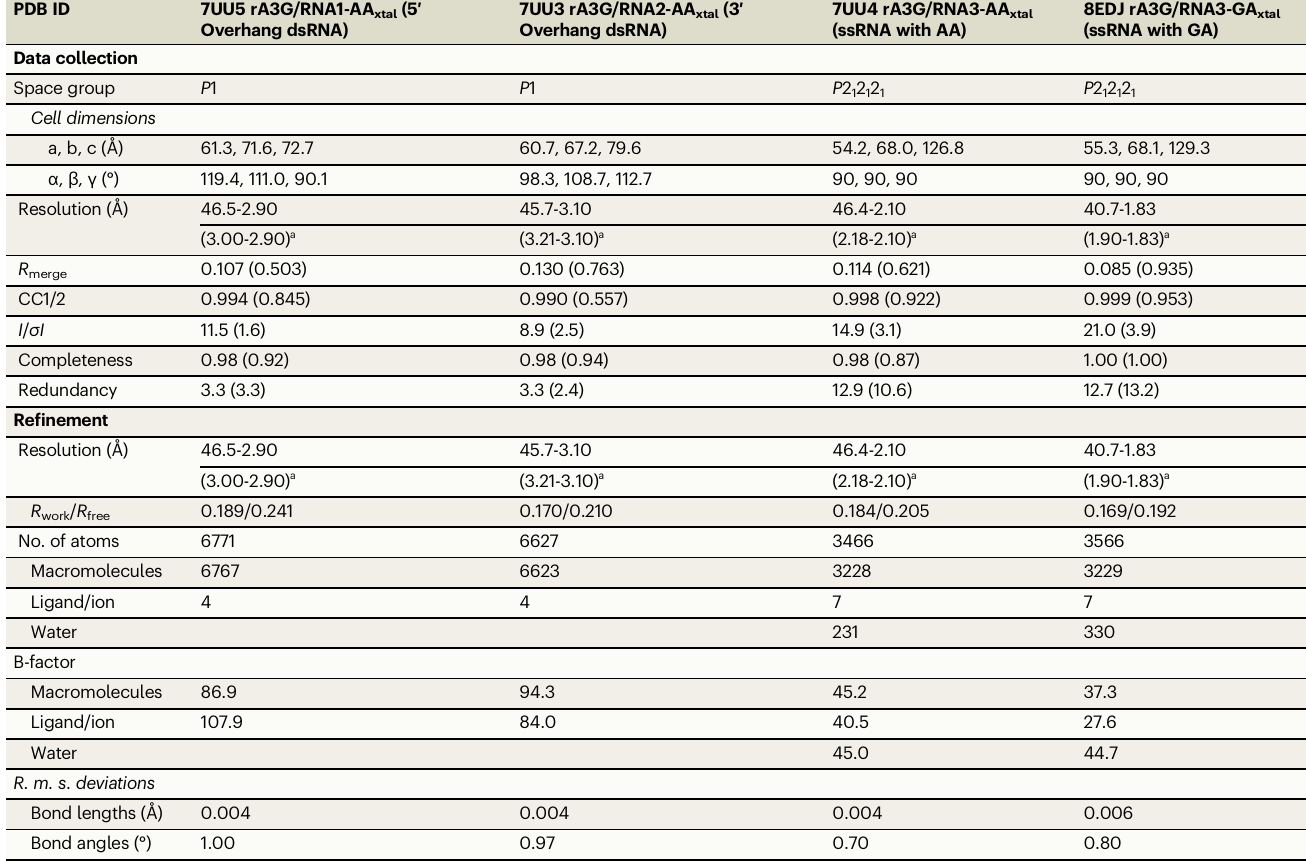
Table 1 | Crystallographic data collection and re fi nement